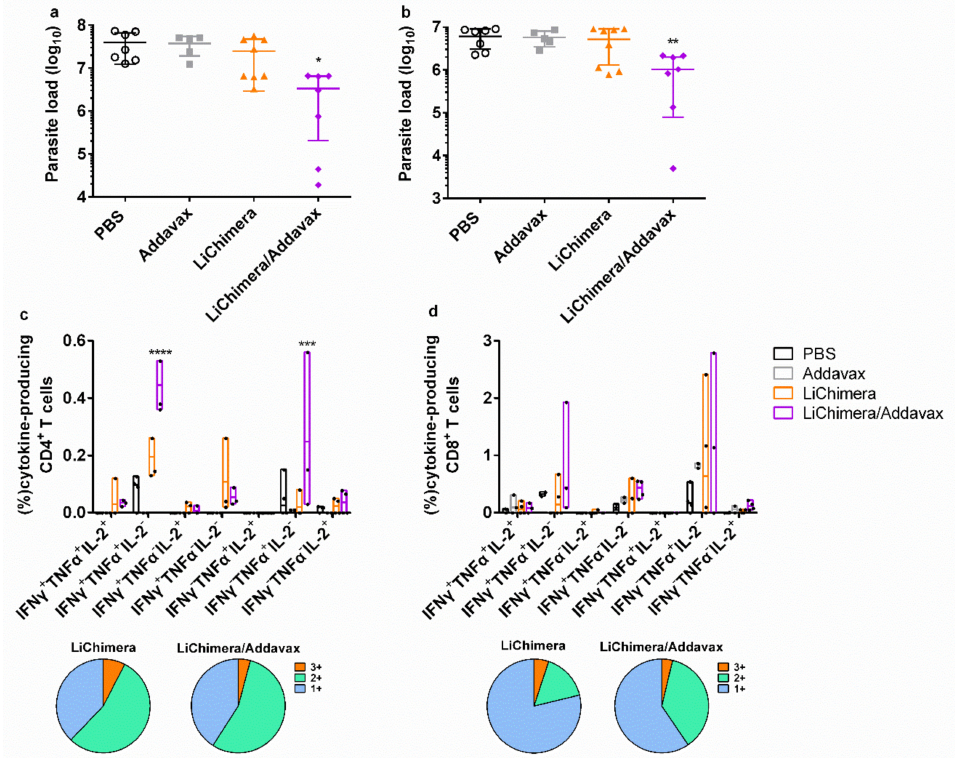
Figure 11. Detection of the protective e ffi cacy of LiChimera vaccination against L. infantum challenge and evaluation of the cellular immune responses in long-term vaccinated mice. The BALB / c mice were vaccinated twice intramuscularly with LiChimera alone or adjuvanted with Addavax. The control groups received PBS or Addavax. Ten weeks post boosting, mice were challenged with 1 × 10 7 stationary phase L. infantum promastigotes. Eight weeks post challenge the parasite load in liver ( a ) and spleen ( b ) was measured; Determination of cytokine-producing cells within the ( c ) CD4 + and ( d ) CD8 + T cell populations. Splenocytes were stimulated in vitro with LiChimera for 12 h and CD4 + or CD8 + T cell were divided into seven distinct subpopulations based on their production of these cytokines in any combination after LiChimera stimulation. The pie charts summarize the fractions of single, double, or triple producers for indicated groups. Flow cytometry results are given as bounds of box and whisker plots. The line represents the median ( n = 3–4 mice per group), the whiskers show the data range, and the box shows the interquartile range. All the other data are expressed as means ± s.d. for n = 5–7 (PBS and Addavax) or n = 8 (LiChimera and LiChimera / Addavax). Significant di ff erences between groups are indicated with asterisks measured by two-way ANOVA and Tukey’s multiple comparison tests. * p < 0.05, ** p < 0.01, *** p < 0.001, and **** p <